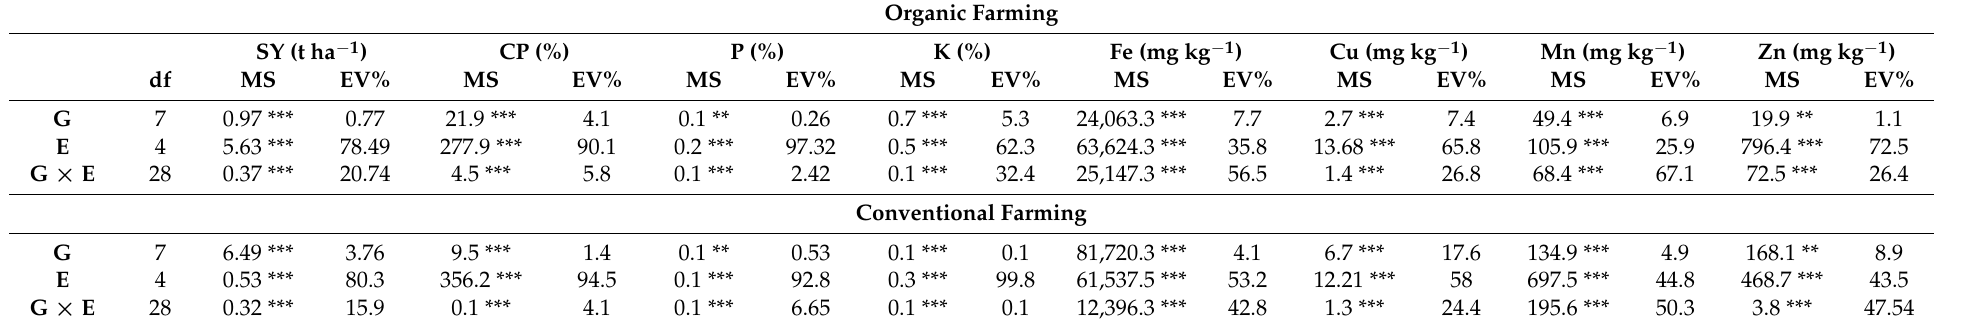
Table 1. Mean squares (MS) analysis of variance (ANOVA) and partitioning of treatment sum of squares (EV%) for seed yield (SY), seed crude protein (% CP), seed macronutrient (% P, K) and micronutrient (Fe, Cu, Mn, Zn, mg kg − 1 ) contents of the five lentil genotypes (G) across eight environments (E) in organic and conventional farming. Organic